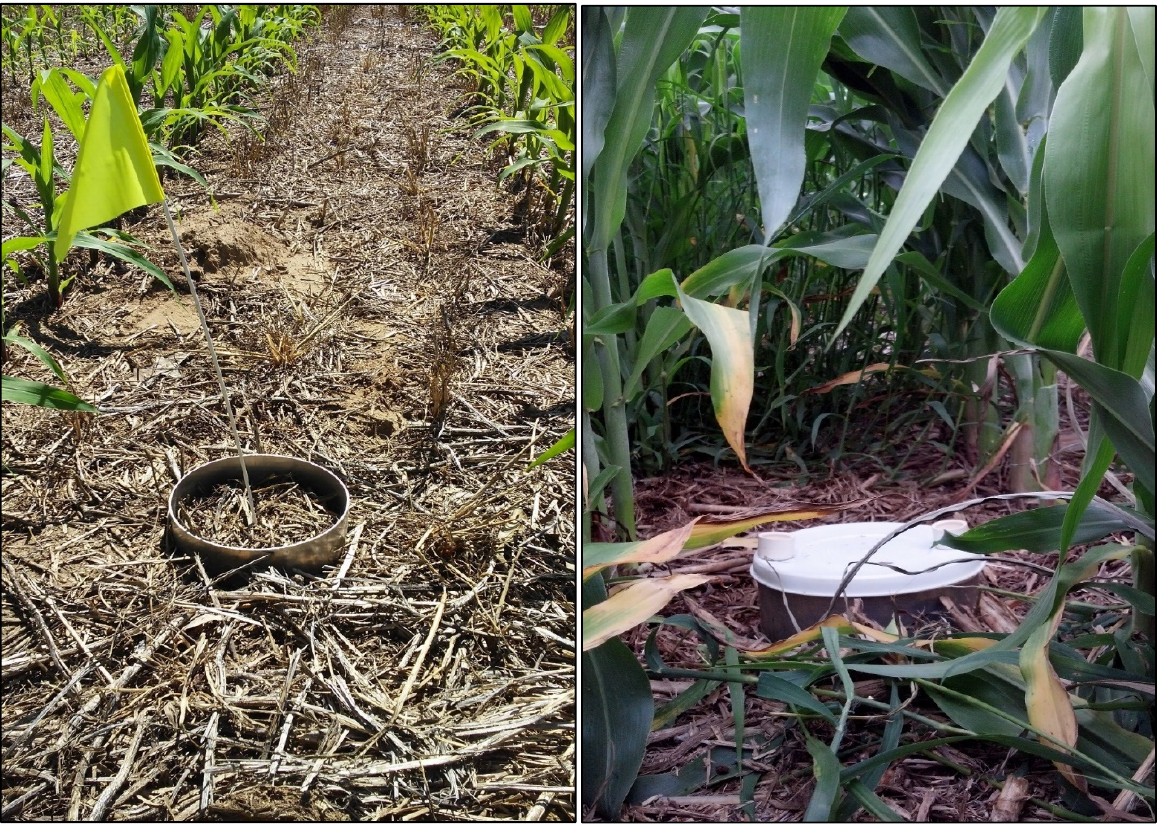
Figure 2. Metal ring after field installation at the pre-sampling ( left ) and at the sampling and post-sampling stage ( right ).